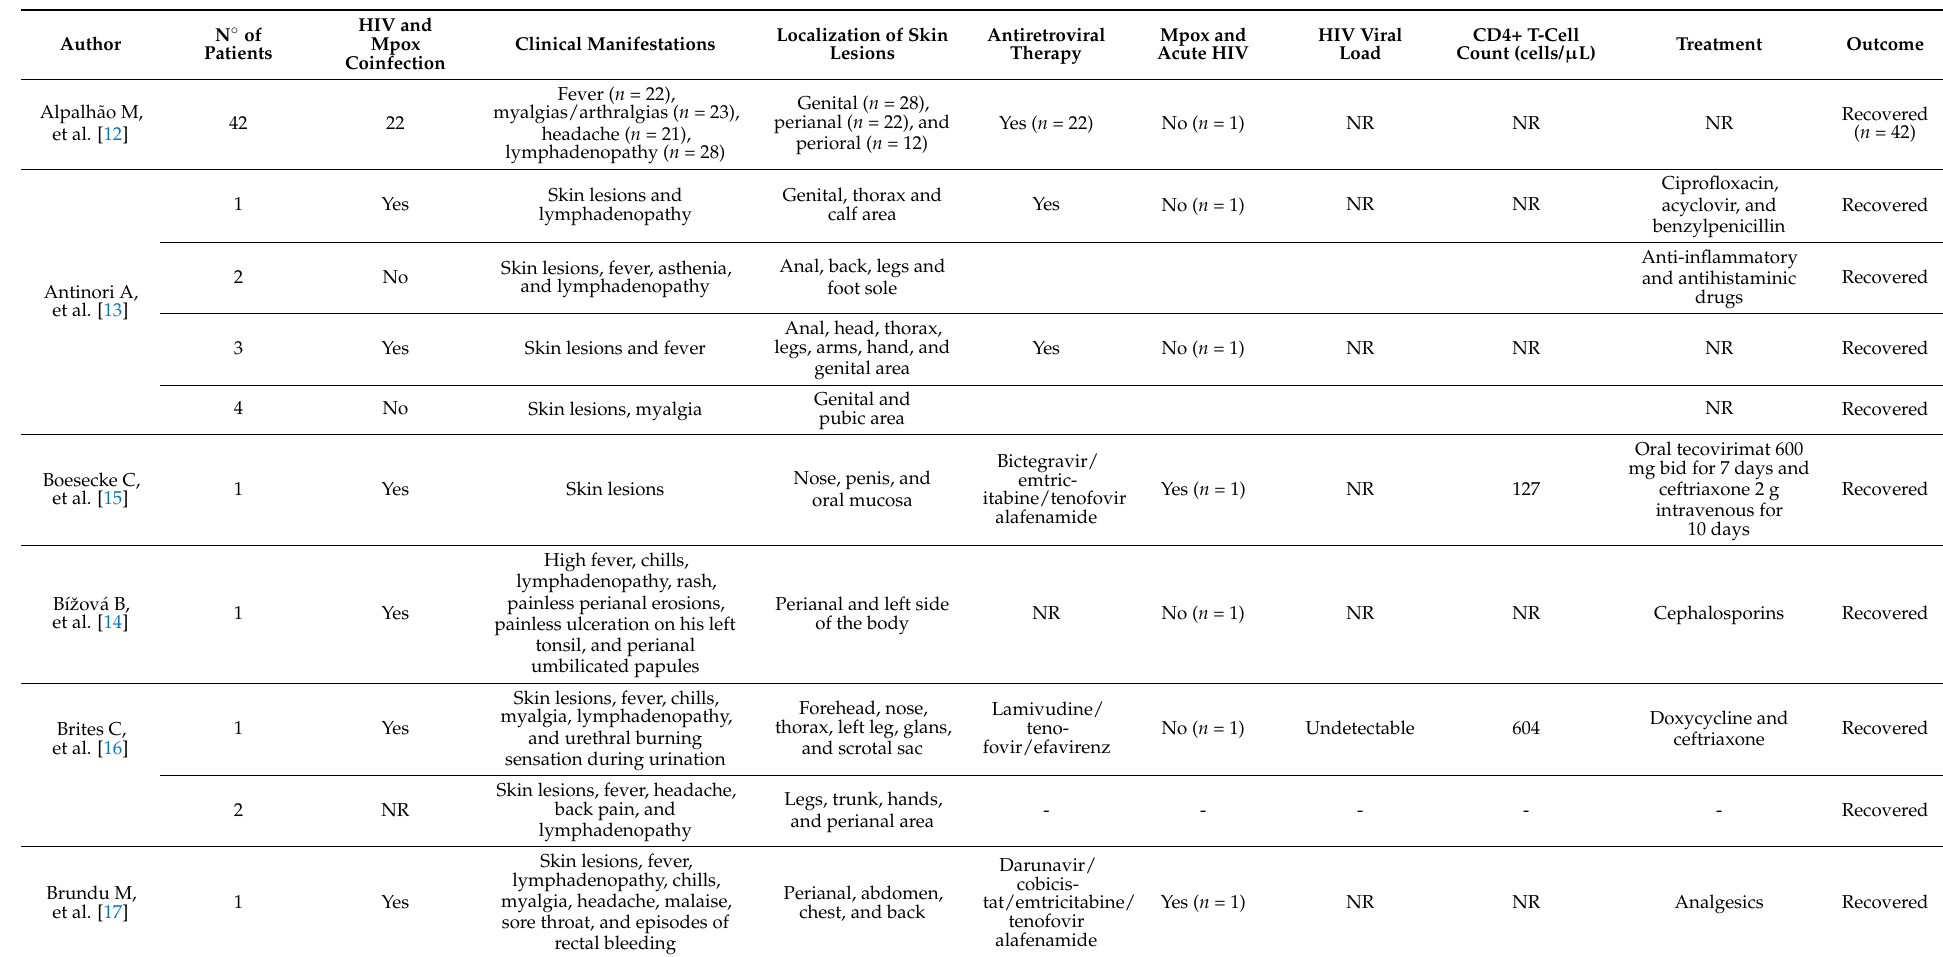
Table 3. Characteristics of eligible studies. HIV status, clinical manifestations, localization, antiretroviral therapy, viral load, CD4+ T-cell count, treatment and